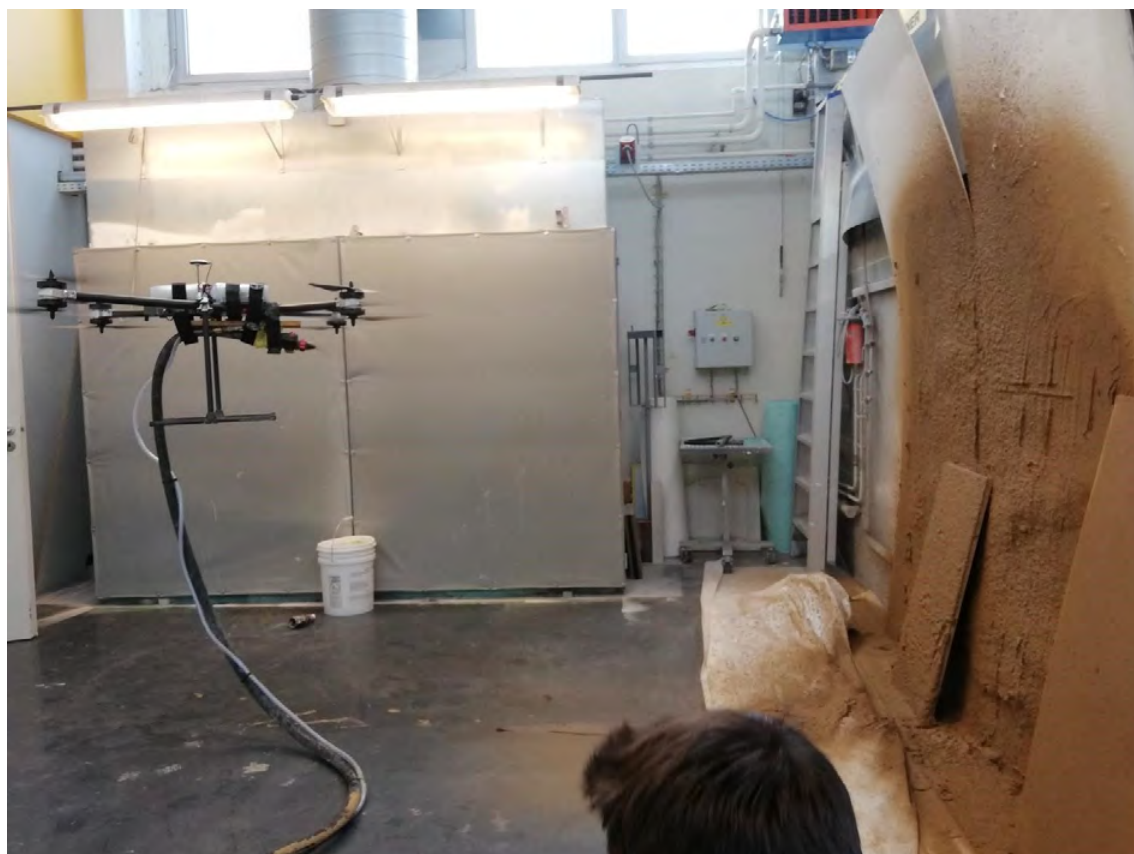
Figure 13. Drone connected to a continuous spraying industrial pump from EUROMAIR resulting in a homogeneous coating of clay mix on some wooden testing boards.